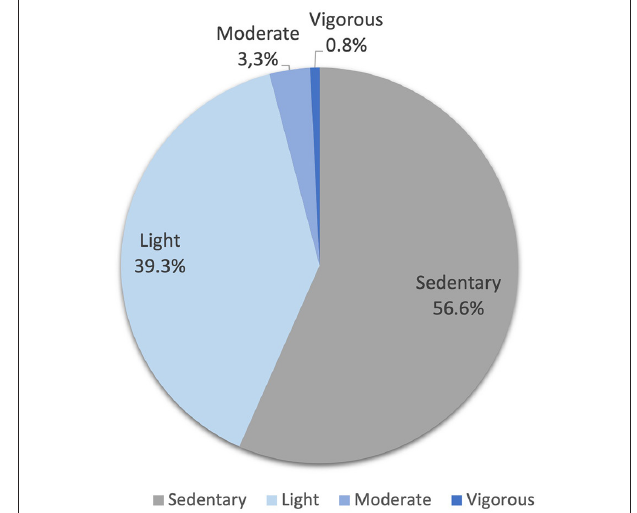
FIGURE 1 | Categories of physical activity (percentage of time) during 7 days.